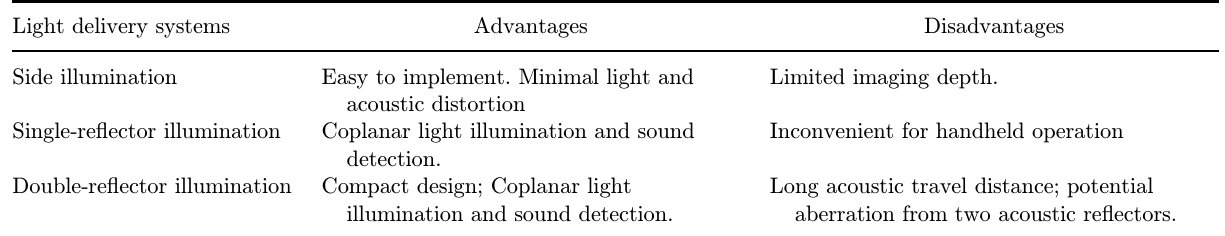
Table 2. Comparison of various light illumination